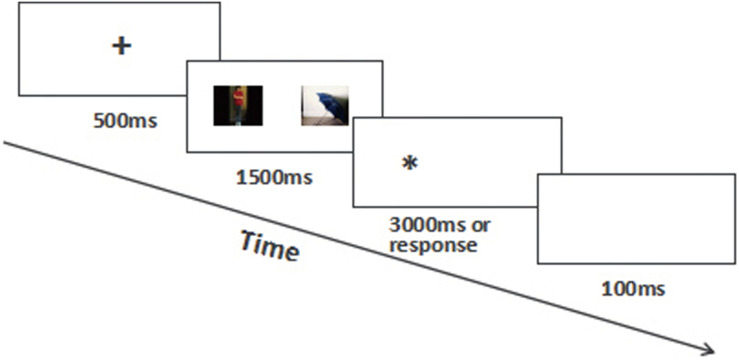
The procedure of Dot-probe task.